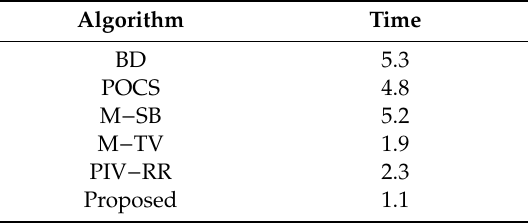
Table 4. Comparison of algorithm running time (min).